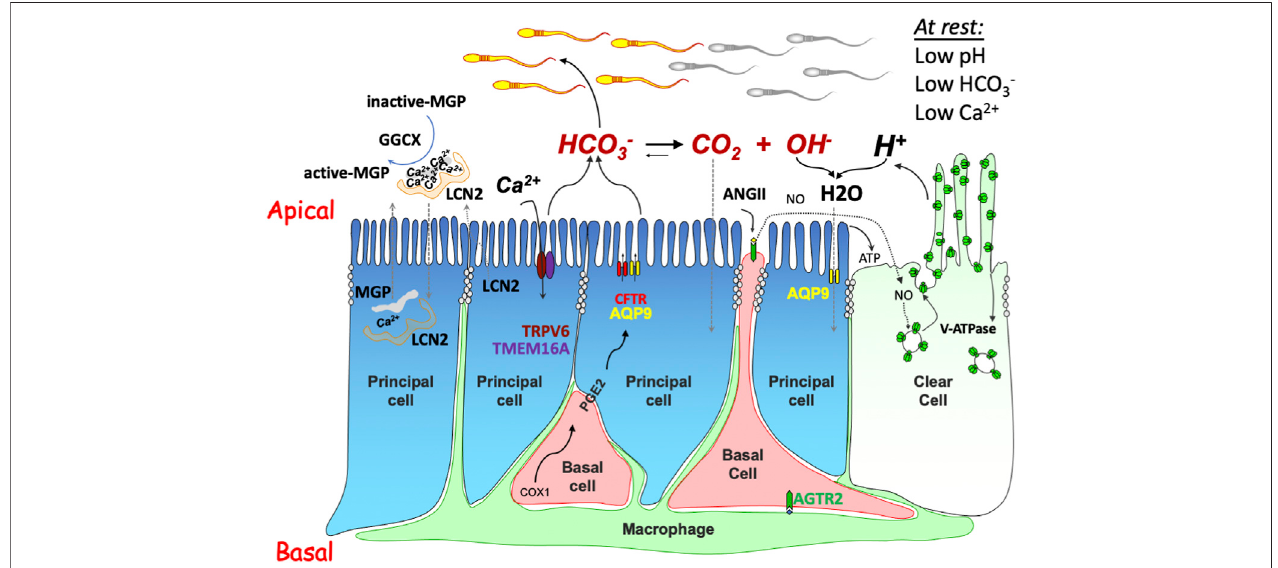
FIGURE 2 | Schematic drawing showing the intercellular communication model regulating the luminal microenvironment in the epididymis. The model includes several physiological processes: 1) anion secretion (e.g., HCO 3 − ) via apically located CFTR (and/or other anion channels, such as TMEM16A) provides an ionic gradient which drives fl uid transport through water channels, e.g., aquaporin 9 (AQP9); 2) proton-pump V-ATPase acidi fi es the luminal content and promotes HCO 3 − hydrolysis for water and CO 2 absorption, an essential acidi fi cation process required for maintaining sperm in a quiescent state and to prevent premature activation. The acidi fi cation process is mediated by either constitutively by recycling of the V-ATPases which are abundantly expressed in clear cells, or by the stimulation of luminal factors, such as ATP generated by principal cells or nitric oxide (NO) from the basal cells upon stimulation by the angiotensin receptor type 2 (AGTR2); and 3) Ca 2+ reabsorption through either the epithelial Ca 2+ channel TRPV6 and Ca 2+ -dependent Cl − -channel TMEM16A electrical coupler or via a process facilitated by GGCX- mediated carboxylation-dependent activation of MGP for Ca 2+ chelation and simultaneous protein aggregation, such as lipocalin 2 (LCN2).